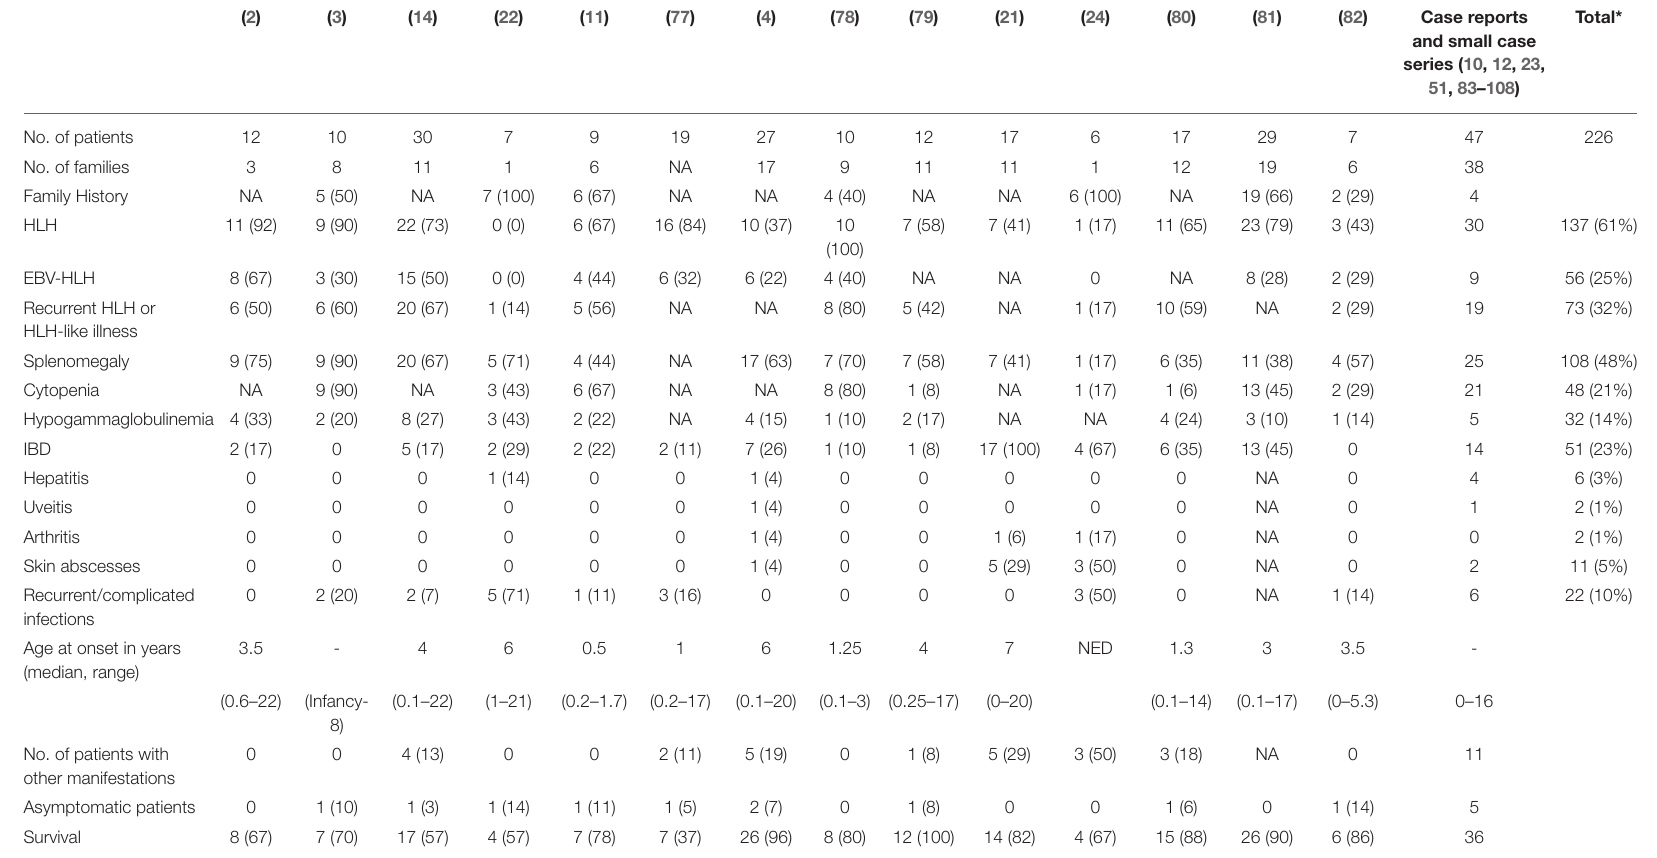
TABLE 1 | Occurrence of common clinical characteristics of XIAP deficiency reported to